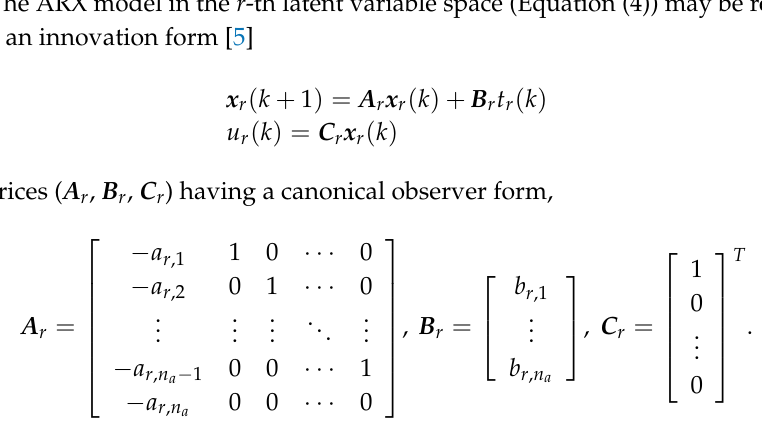
Figure 1. PLS control framework proposed by Kaspar and Ray.